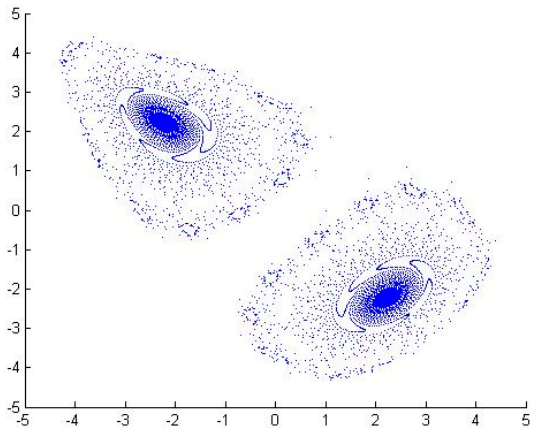
Figure 5. Two domain of attraction.